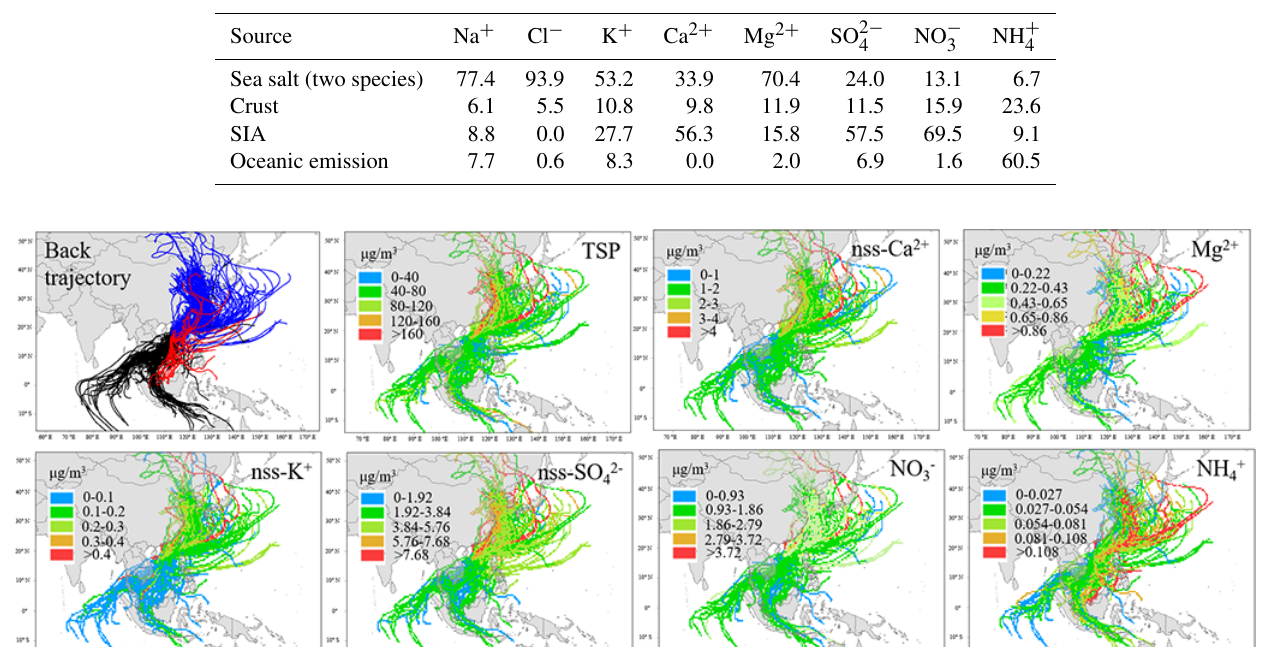
Figure 11. 10-day back trajectories of warm (black, June through September 2014), cool (blue, March and April 2014 and October 2014 through February 2015) seasons, and transition seasons (red, May 2014) at Yongxing Island. Additionally, CWT (concentration-weighted trajectory) plots for daily weighted-average concentrations of TSPs, Ca 2 + , Mg 2 + , K + , SO 2 − burning also produce Na + and Cl − (Liu et al., 2000;